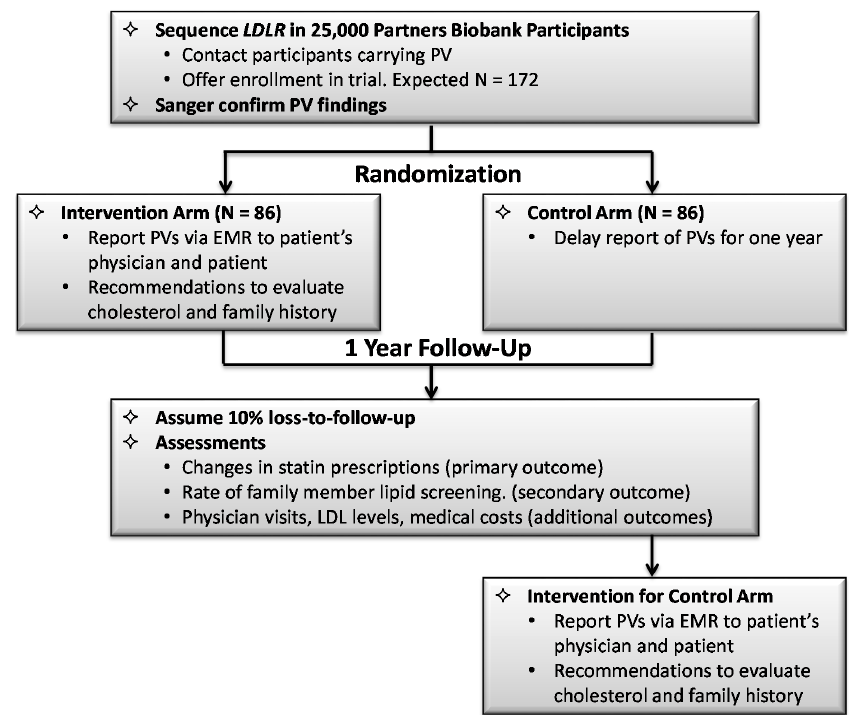
Figure 1. Design of implementation trial at the Partners eMERGE site.